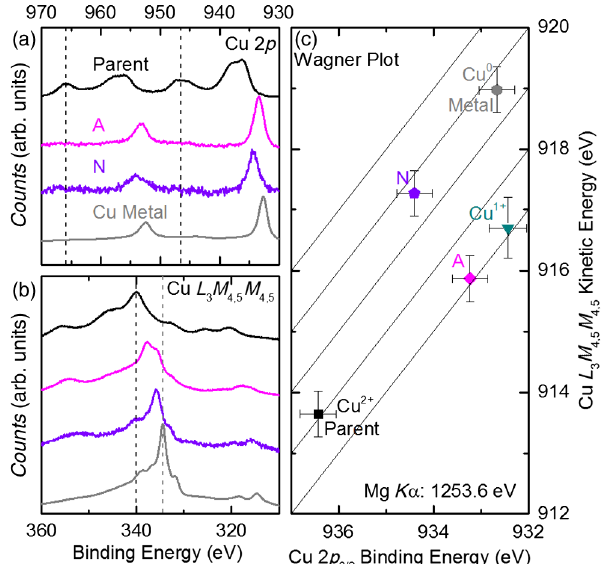
FIG. 2. X-ray photoelectron spectroscopy (XPS). (a) Cu 2 p XP spectra of parent herbertsmithite (black), sample A (magenta), sample N (violet), and Cu metal (gray). The black dashed line indicates locations of satellite peaks in the parent, characteristic of Cu 2 þ , which are significantly reduced in the doped samples. (b) The x-ray generated Auger Cu L 3 M 4 ; 5 M 4 ; 5 spectra of the same four samples. The black and the gray dotted lines represent the location of the greatest intensity peak for the parent and the copper metal, respectively. The peak shape and binding energy of the doped samples varies significantly from both the parent and the copper metal. (c) A Wagner plot shows the relative chemical shift of the four samples and Cu 1 þ in Cu ð I Þ 2 O (literature value) [18] by plotting the kinetic energy from the Cu L 3 M 4 ; 5 M 4 ; 5 peak on the y axis and the binding energy from the Cu 2 p 3 = 2 peak on the x axis. The chemical shift is sensitive to the polarizability of the chemical